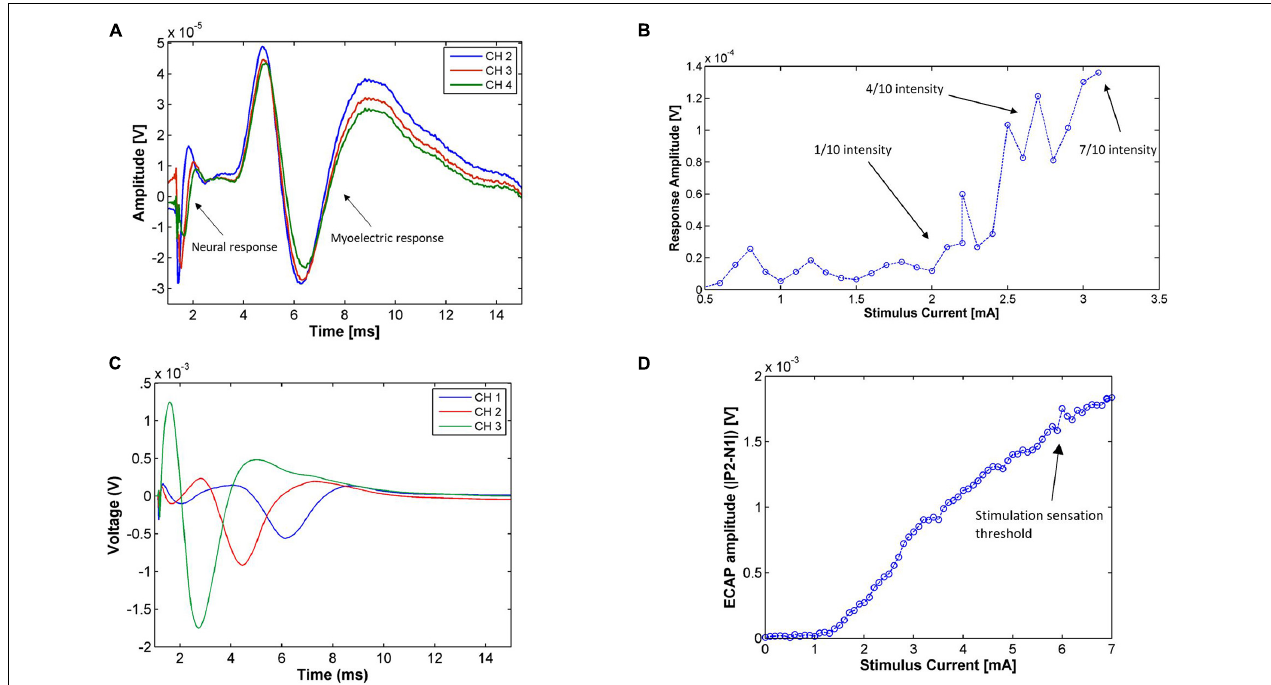
FIGURE 3 | (A) Electrophysiological responses from Patient 01 during the Trial Programming Visit from monopolar stimulation on CH1 at the patient’s maximum level (14 Hz, 0.6 mA, 210 µ s pulse width, average of 194 shots). The electrophysiological response is composed of a propagating neural response [with a medium conduction velocity ( ∼ 45 m/s)] followed by a myoelectric response. (B) Amplitude of the medium-velocity neural response [measured as P2-N1 peak-to-peak amplitude of the average trace at each current (minimum 7 shots per stimulus current)] in Patient 06 during the Trial Programming Visit for stimulation on CH1 and recording on CH4 (14 Hz, 30 µ s pulse width). The patient reported a very mild stimulation sensation intensity (scored as 1 out 10) at 2.1 mA, a present but comfortable stimulation intensity (scored as 4 out of 10) at 2.8 mA, and a strong but not uncomfortable stimulation sensation (scored as 7 out of 10) at 3.1 mA. (C) Responses for stimulation on CH4 of Patient 04 (14 Hz, 6.8 mA, 100 µ s pulse width, average of 322 shots) during the Trial Programming Visit. The conduction velocity of this response was approximately 3.5 m/s. (D) Amplitude of the slow neural response [measured as the P2-N1 peak-to-peak amplitude of the average trace at each current (minimum 7 shots per stimulus current)] on CH4 for the range of applied stimulus currents in Patient 04. Stimulation was applied on CH2 (14 Hz, 100 µ s pulse width). The neural response amplitude rises linearly with the stimulus current after a threshold, however, as opposed to the medium-velocity neural response, the response amplitude does not reflect the intensity of the stimulus sensation. The patient reported a sensation only after the neural response amplitude surpassed 1.5